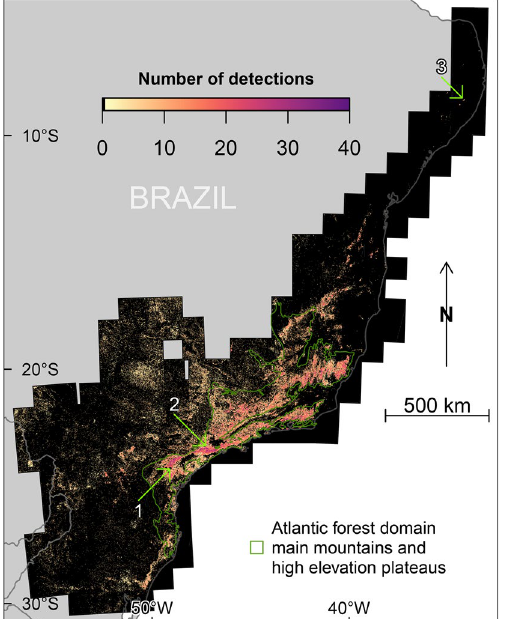
Figure 3. Pink and magenta blossoms detections in the Atlantic Forest domain in percentage of cloud free images (%) during the 4-year period between June 2016 and July 2020. Each pixel is a square of 1.28 km × 1.28 km. A detection indicates that the model has found pink-magenta blooming trees in the Sentinel-2 image over this area. Pixels with less than 4 detections during the study period were set to zero. Arrows 1 and 2 indicate regions in the north of the city of Curitiba and in the south of the São Paulo city, respectively. Arrows 3 indicates the northern detected forests with pink and magenta blooming